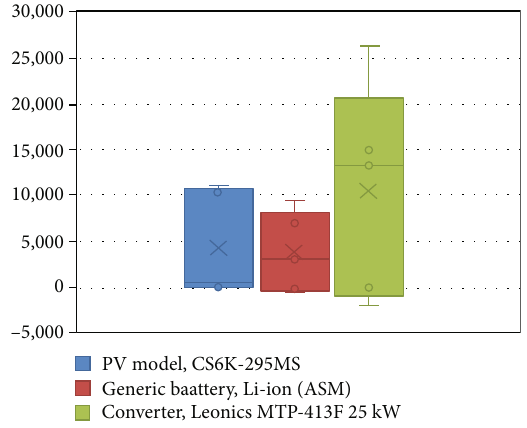
Figure 9: Cost summary (US$) from Homer Pro simulation results for PV, battery, and